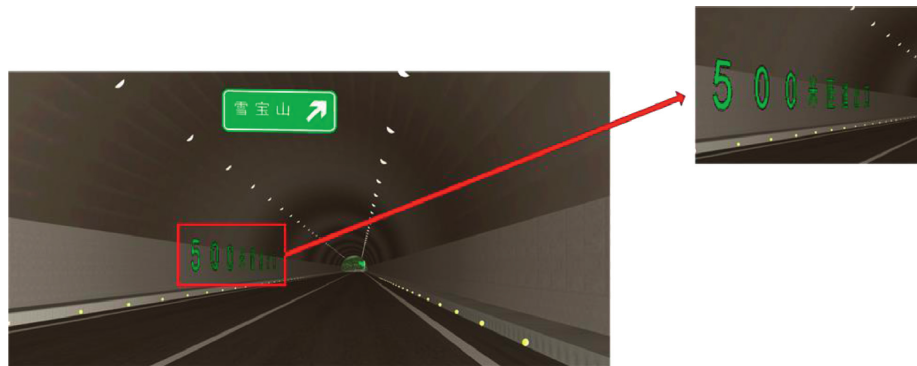
Figure 2: Location sign+distance